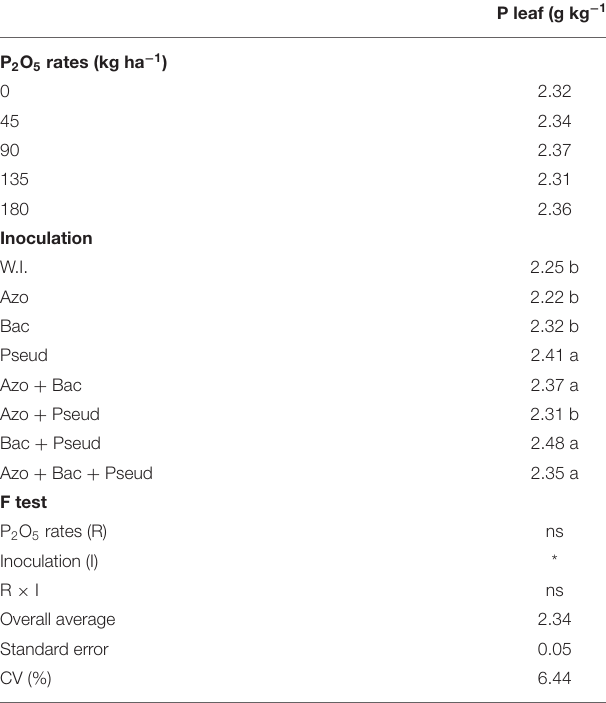
TABLE 5 | Leaf dry mass, stalk dry mass and total dry mass (entire plant) of sugarcane as influenced by different bacterial inoculations and P 2 O 5 doses. P leaf (g kg − 1 ) Leaf dry